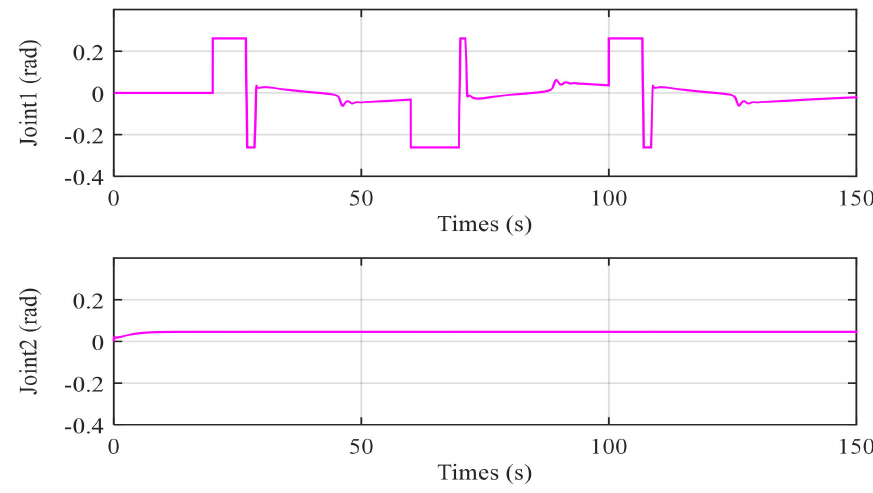
Figure 11. The input of the